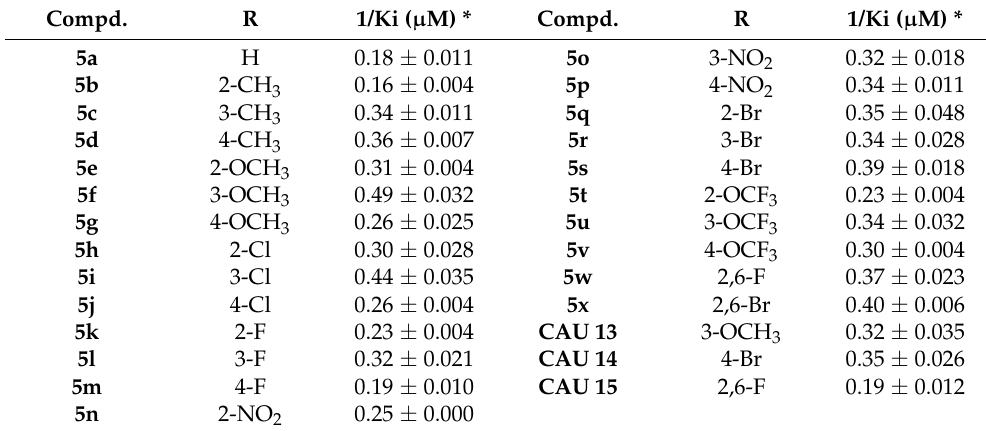
Table 2. Binding affinity of target compounds with ApisOBP9.